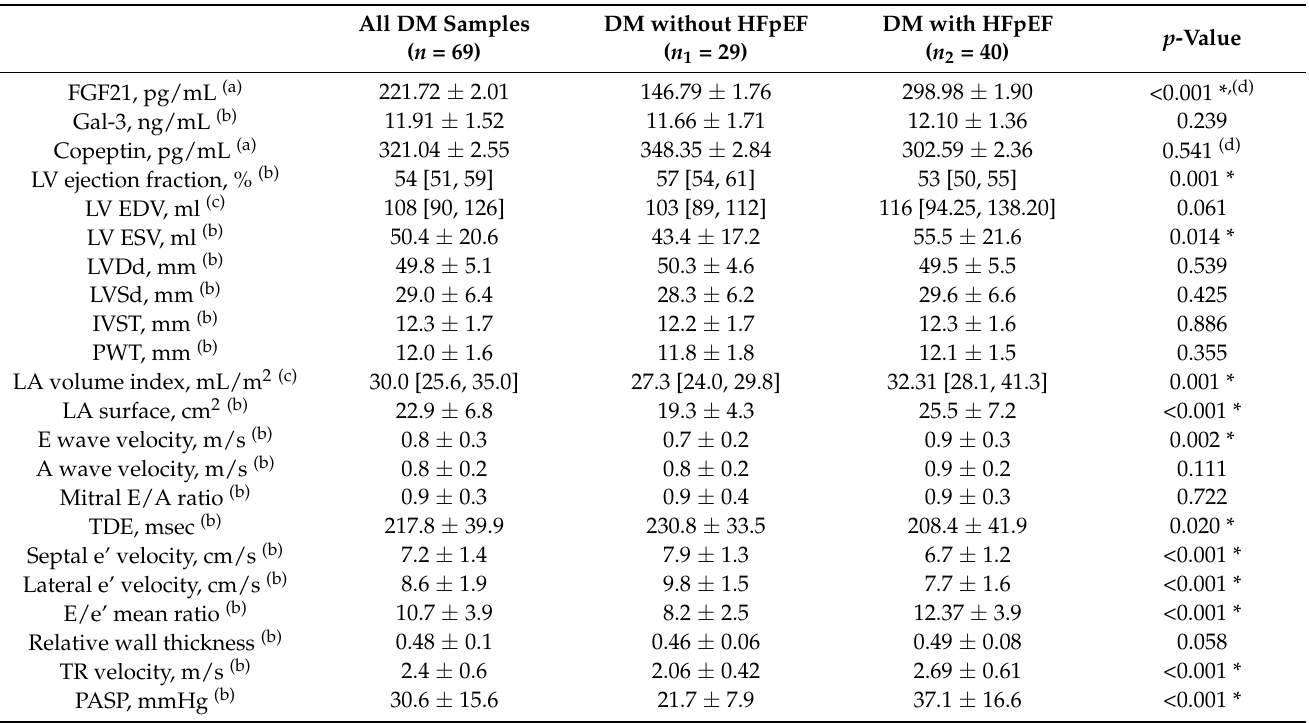
Table 2. Comparison of FGF21, galectin-3, copeptin and echocardiographic parameters between the studied groups. All DM